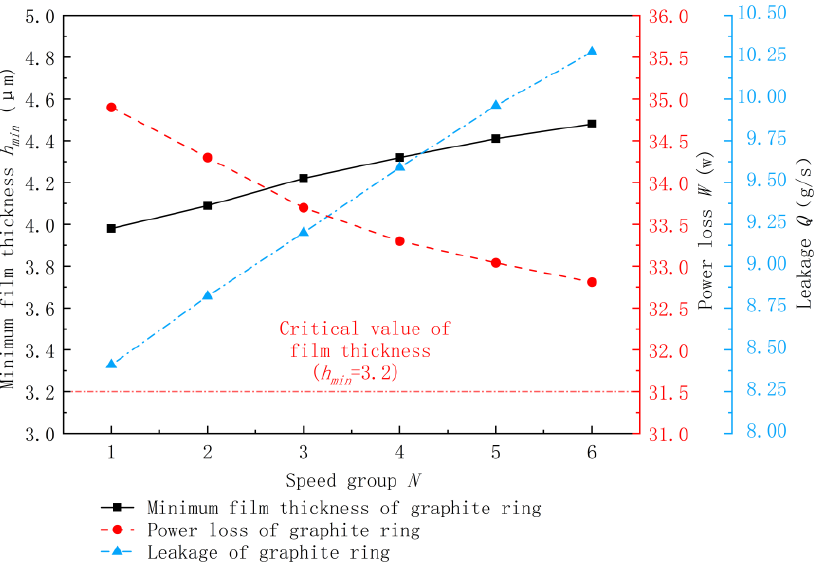
Figure 13. Effects of synchronous changes in the speed of the inner and outer rotors on sealing per- formances.